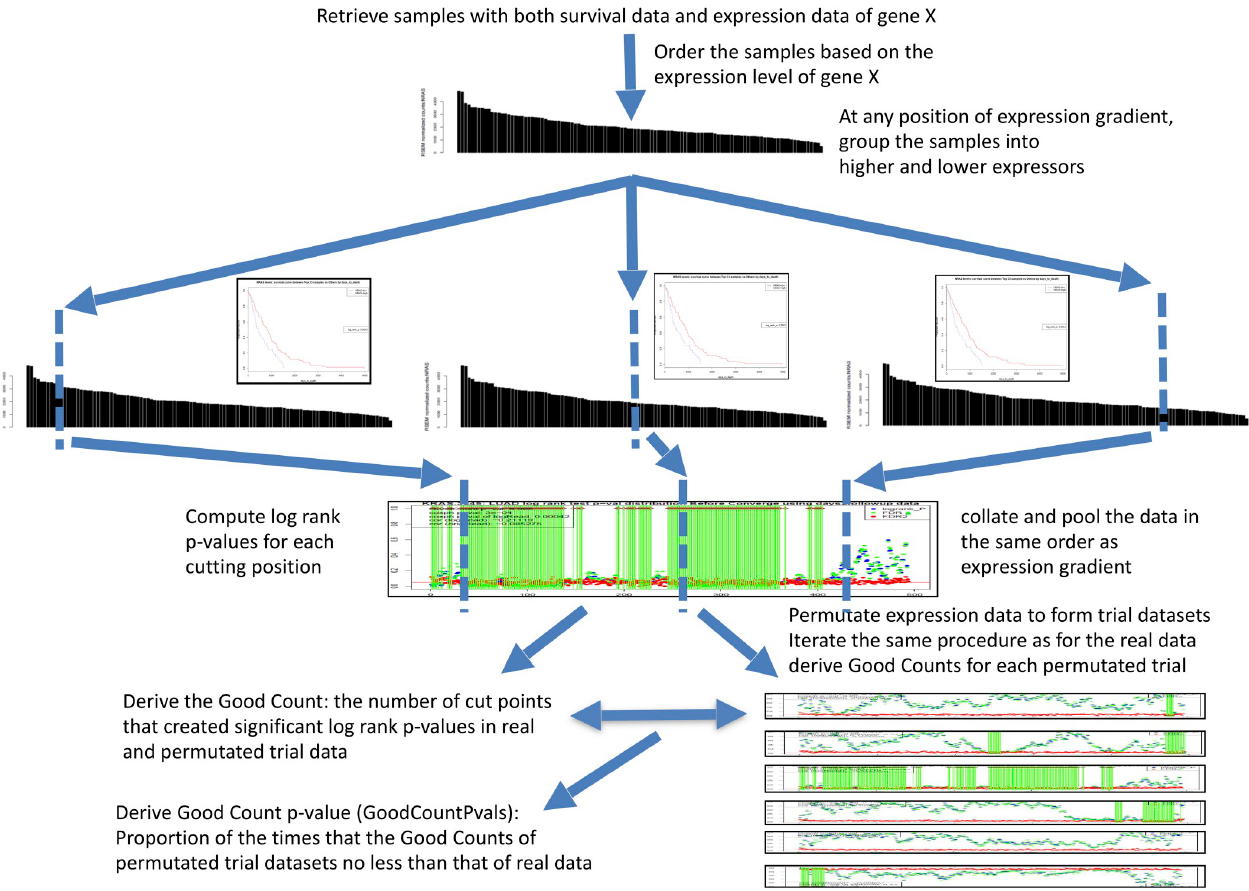
Fig 1. GradientScanSurv procedure for exhaustive association test of gene expression with survival outcome. Expression data was permutated to form trials of datasets (n > = 1000). GoodCounts were derived for each trial dataset and real dataset as the numbers of cutpoints that created significant logrank test p-values. From this, the GoodCount p-value (GoodCountPvals) is derived as the proportion of the times that the GoodCounts of permutated trial datasets is no less than that of real data. See Material and methods for details.